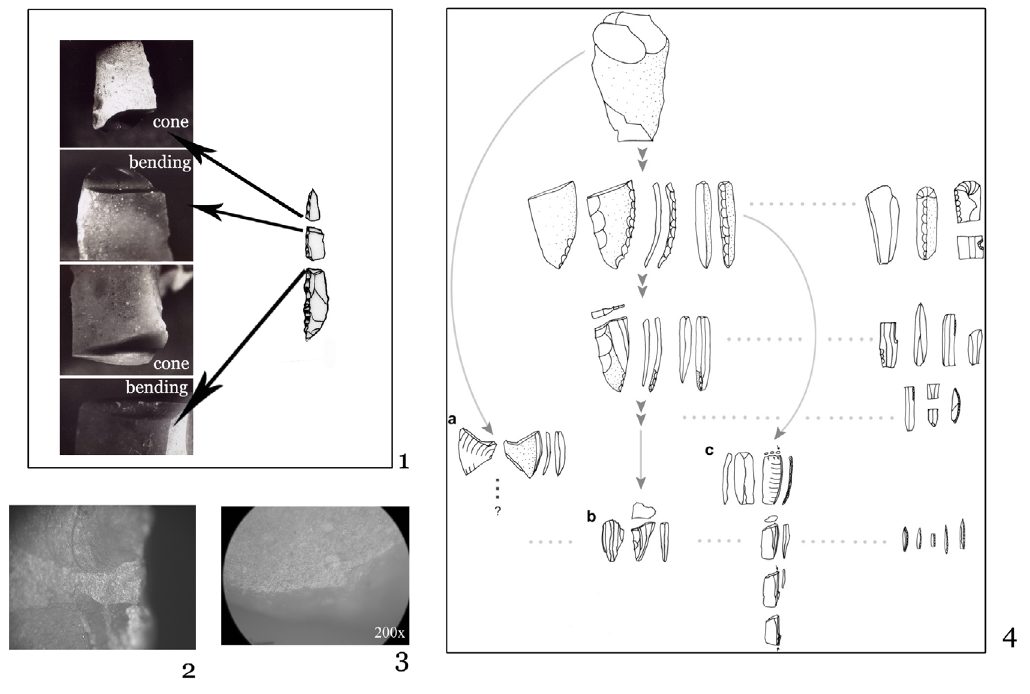
Figure 3. 1) Mutual position of bending and cone fracture after an impact (Borgia, 2006), a:cone/languette; b: bending/plume. 2) Microwear on the lateral edge of an experimental point hafted laterally (Borgia, 2008). 3) Microwear on the proximal part of an archaeological backed point. 4) Chaîne opératoire of Paglicci layer 23 (Wierer, 2013, fig. 31, p. 245), a: small blades on thick preparation flakes, b: integrated blade-bladelets production c: bladelet production on thick blanks (burin